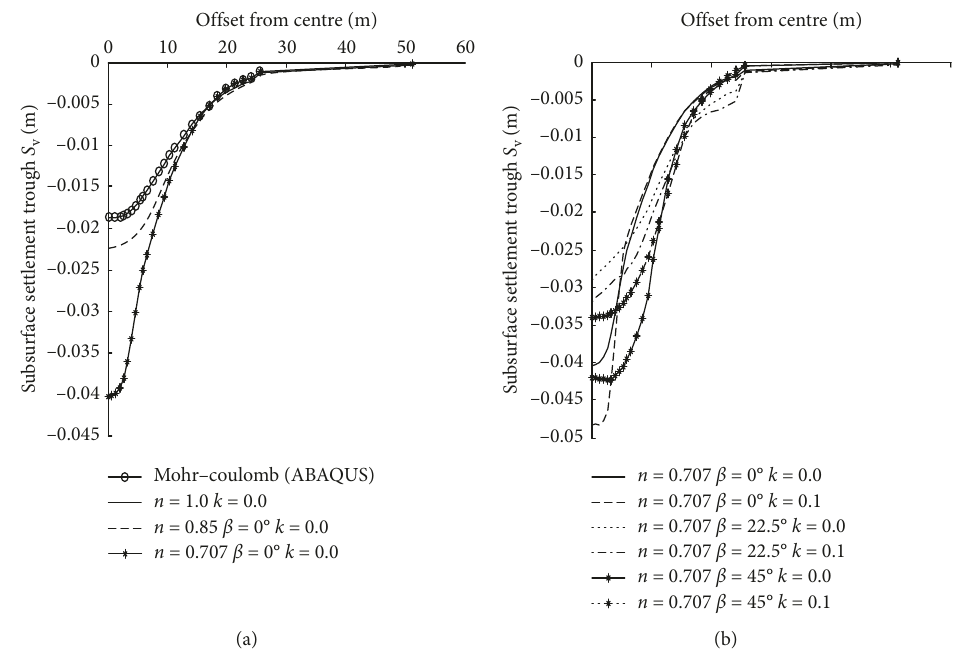
Figure 5: Vertical displacement with the influences of [27]: (a) soil anisotropy ( λ